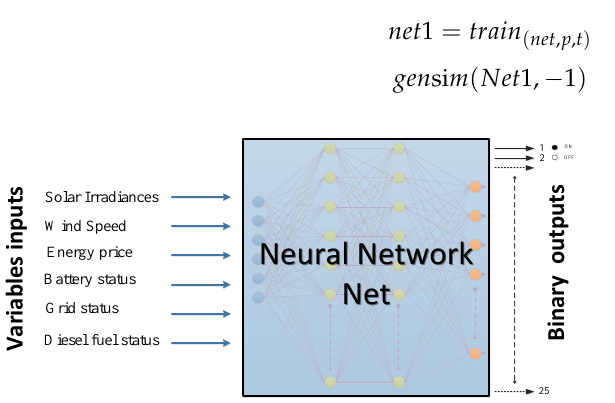
Figure 3. Flow chart of the artificial neural network net training.